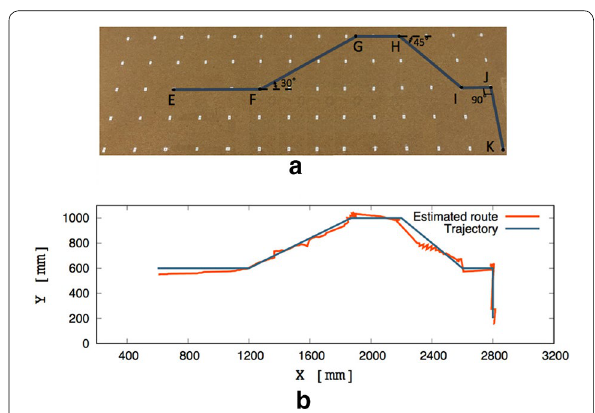
Fig. 12 Real-time self-localization with different orientations. a Experimental environment for estimating the real-time localization on a trajectory (blue line) with different orientations; b result of the real-time estimation with different orientations